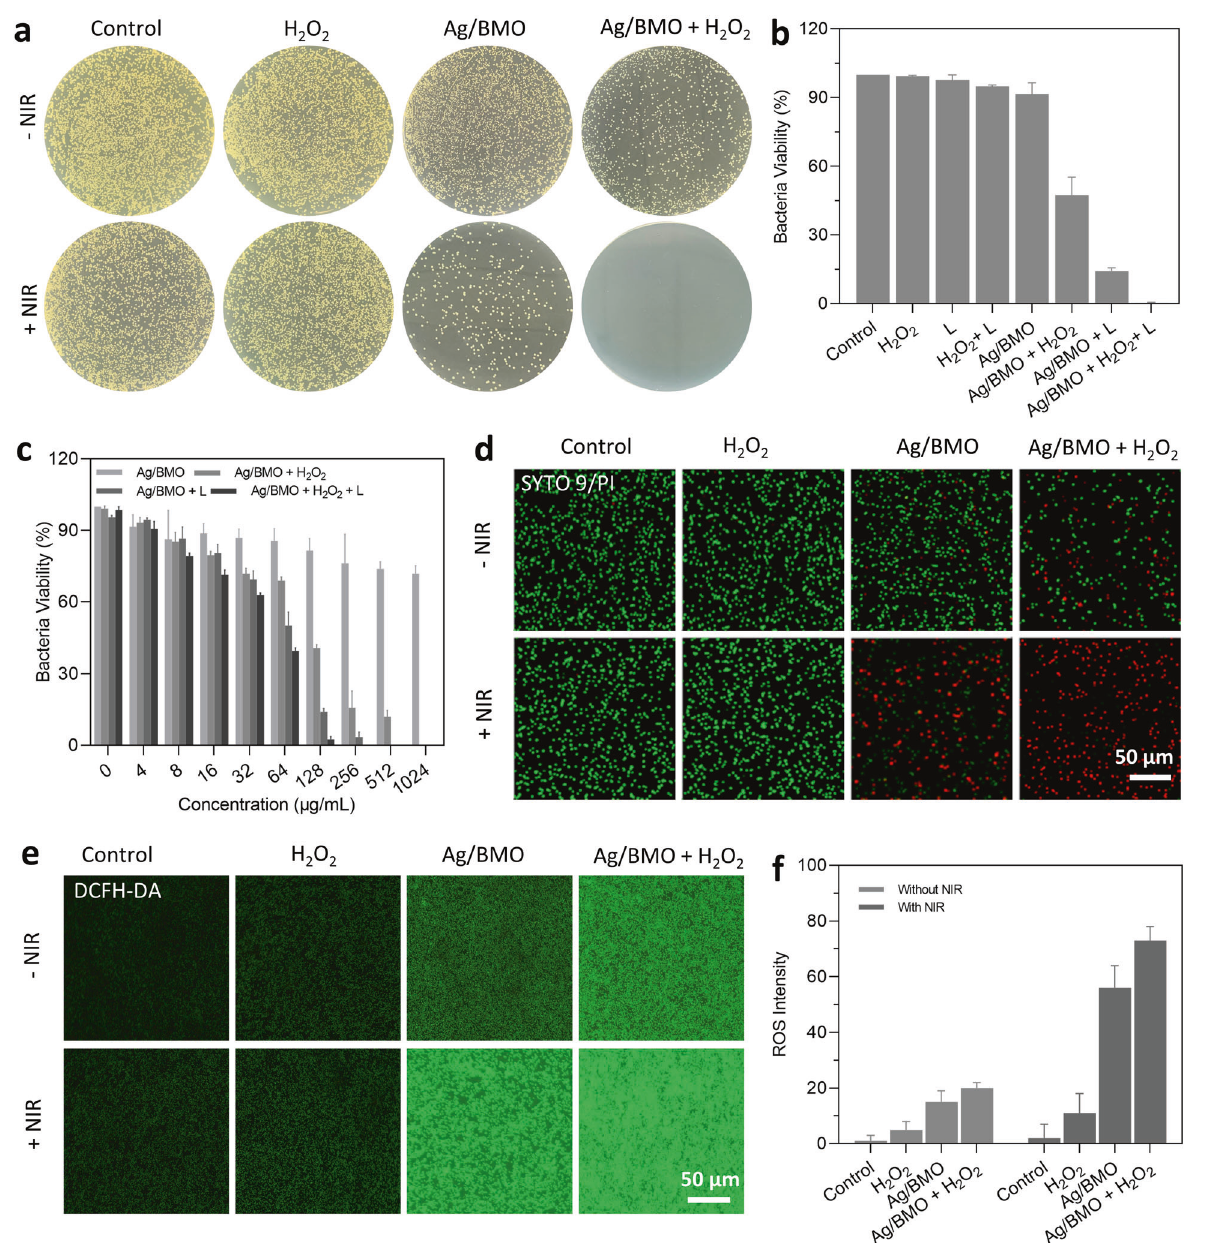
Fig. 3 In vitro antibacterial performance of Ag/BMO nanozyme. 1064 nm laser: 1 W cm − 2 for 10 min, H 2 O 2 : 3 mM, Ag/BMO NPs: 200 μ g mL − 1 . If not otherwise speci fi ed, all NPs were dissolved in DI water for detection. a Plate photographs demonstrating the antibacterial activity of Ag/ BMO NPs. b Corresponding quantitive survival ratio of MRSA in ( a ). c Bacteria viability by monitoring absorbance change at 600 nm (The concentration of NPs solution ranged from 0 to 1024 μ g mL − 1 ). d CLSM images of MRSA stained by LIVE/DEAD dye following incubation with Ag/BMO NPs with or without NIR laser irradiation. (PI emits red fl uorescence and SYTO9 emits green fl uorescence). e , f Fluorescence images and the corresponding quanti fi ed analysis result using DCFH-DA fl uorescent